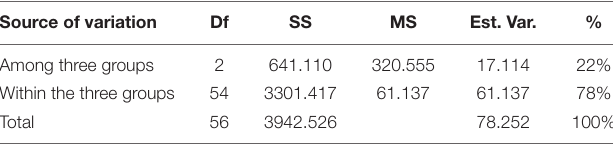
TABLE 6 | AMOVA analysis of cumulative band data for all accessions considered as groups of tetraploid, pentaploid, and other species accessions. Source of variation Df SS MS Est. Var.